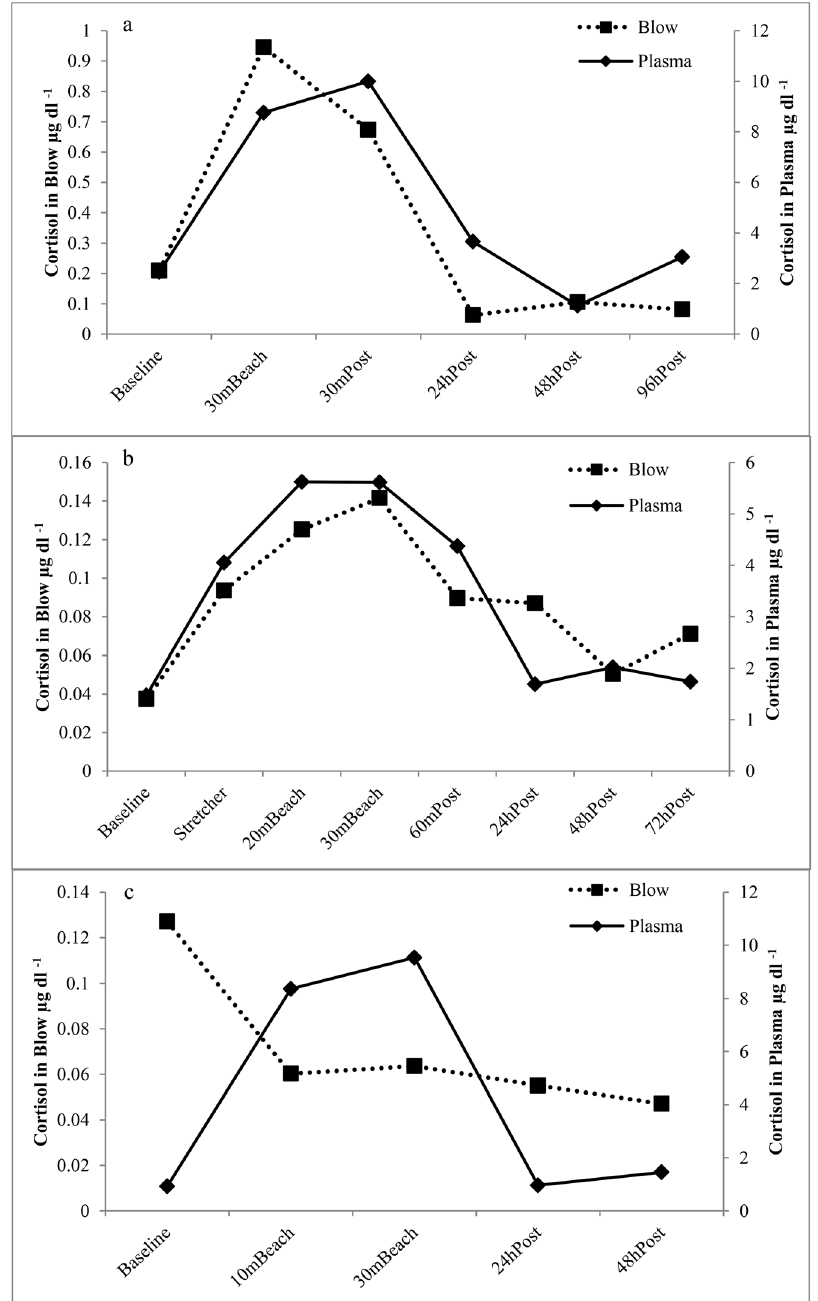
Figure 8. Blow and Plasma cortisol concentrations measured in a) animal 1, b) animal 2, and c) animal 3, over the time course of an OWE. Missing time points reflect samples with volumes too low to run with the assay or where results fell outside the 20–80% B/Bo